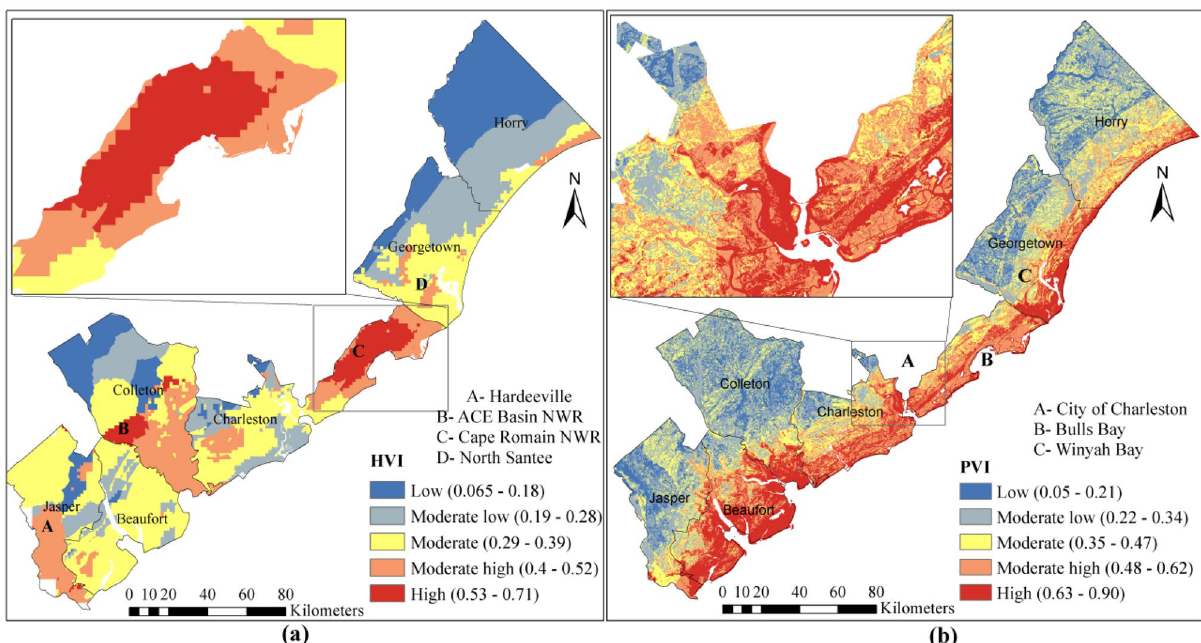
Figure 9. ( a ) Hydroclimate vulnerability, ( b ) physical vulnerability of SC